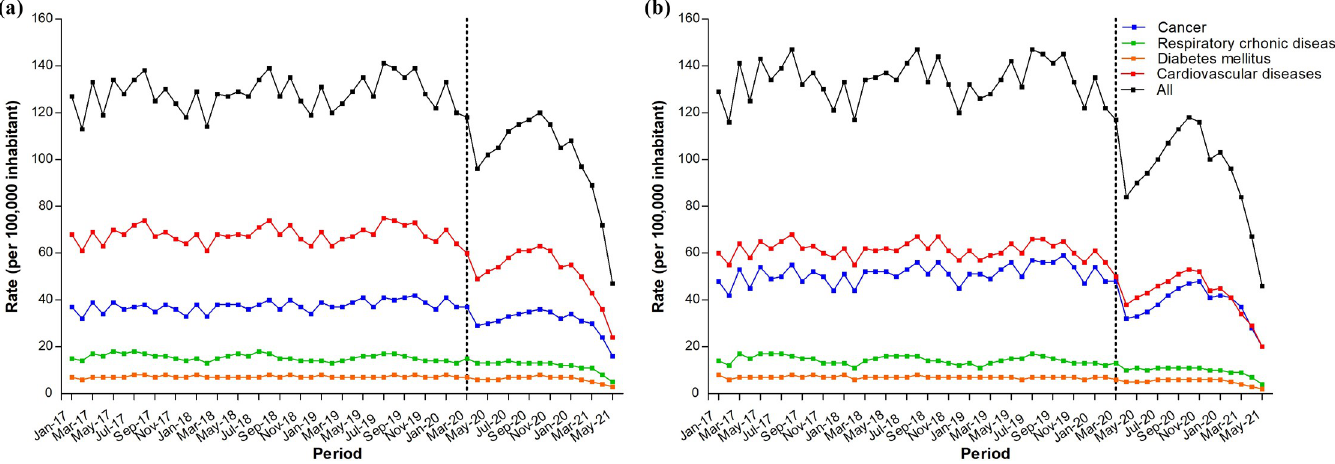
Fig 2. Hospital admission rate for chronic non-communicable diseases (NCDs) in Brazil according to the type of NCD and sex: (a) male and (b) female. Pre-pandemic period: January 1, 2017 to February 29, 2020; Pandemic period: March 1, 2020 to May 31,